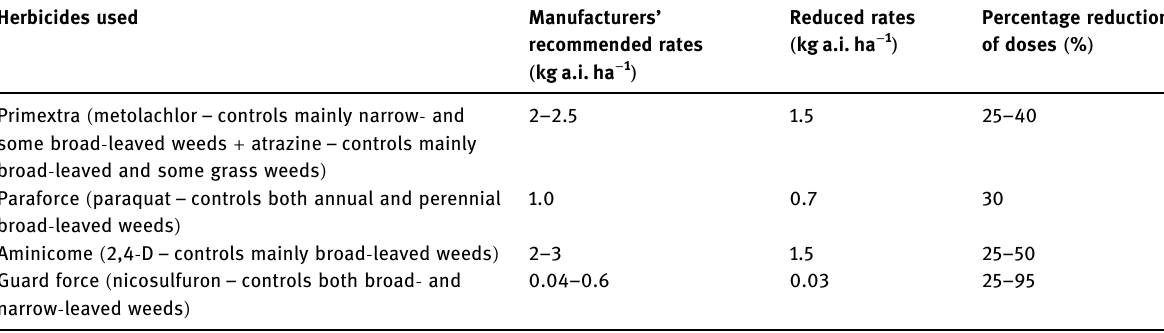
Table 1: Manufacturers ’ recommendations and percentage reduction of herbicides Herbicides used Manufacturers